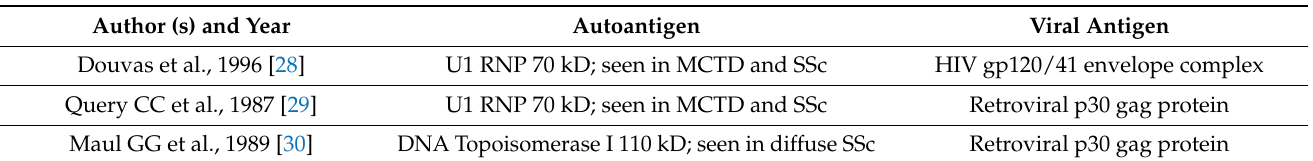
Table 3. A summary of the sequence congruity between viral proteins and human autoantigen